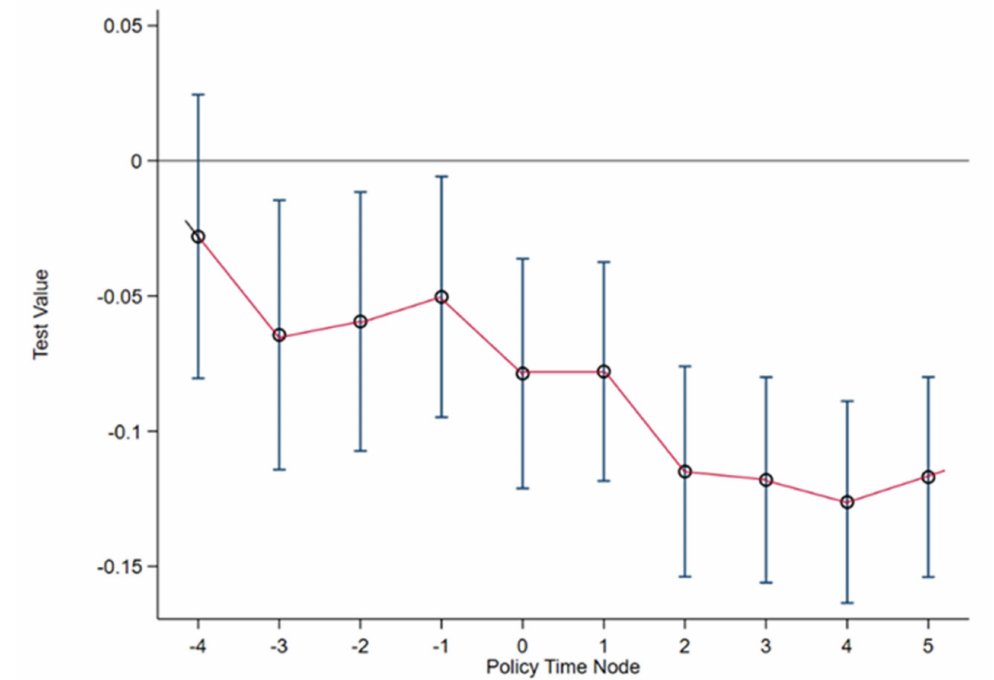
Figure 4. Parallel trend test